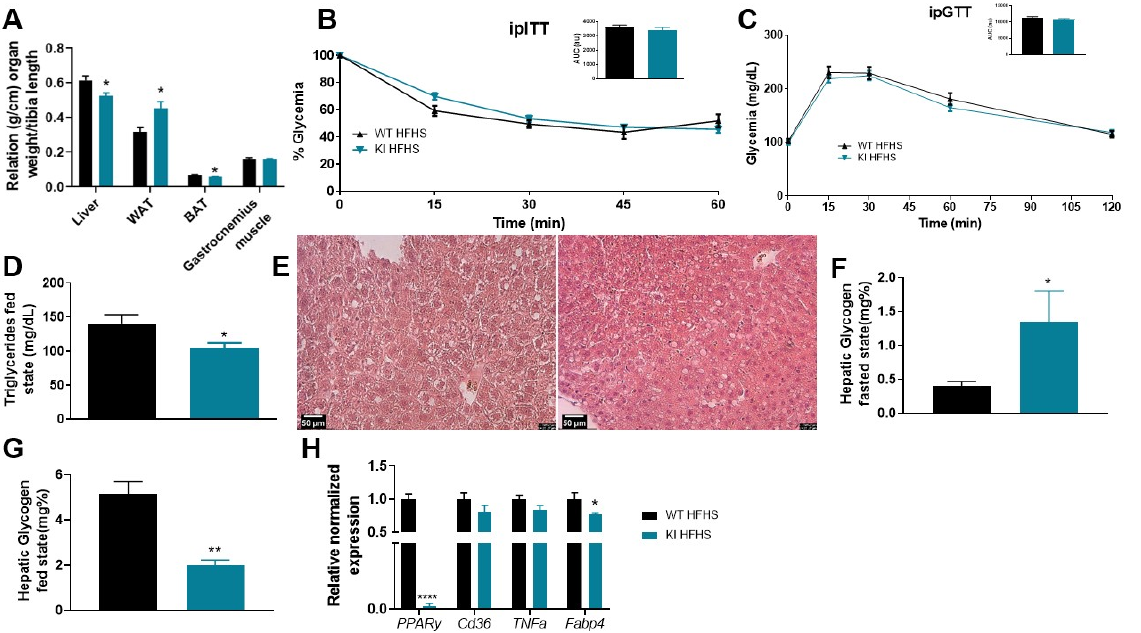
Figure 3. KI S273A lineage after 8 weeks of high-fat high-sucrose diet (HFHS), since weaning, comparing with WT animals. ( A ) Relation of organ weight/tibia length on euthanasia day. ( B ) Intraperitoneal insulin tolerance test (ipITT) with its respective area under the curve (AUC). ( C ) Intraperitoneal glucose tolerance test (ipGTT) with its respective AUC. ( D ) Plasma triglycerides levels in fed state. ( E ) Liver representative image. (F) Hepatic glycogen in fasted and ( G ) fed states. ( H ) Relative normalized expression of PPAR γ , Cd36 , TNF α , and Fabp4 in liver, data were normalized to the expression of reference genes: 36b4 and Rpl27 . Data are represented as mean ± SEM. Statistical analysis was conducted using non-parametric t -test. * p < 0.05, ** p < 0.01, **** p < 0.0001. n ≥ 5 per